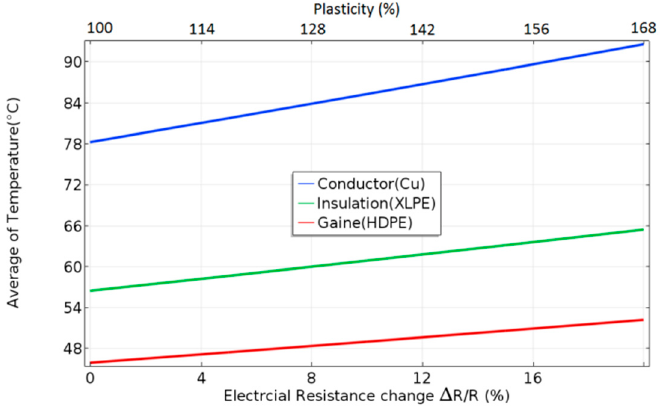
Figure 11. Average temperature in the cable as a function of the plasticity level.